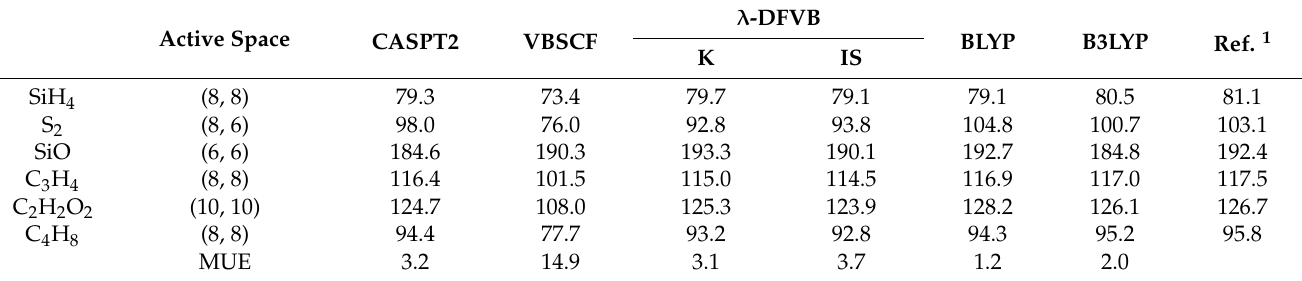
Table 3. Atomization energies per bond (in kcal/mol) of the six molecules in the AE6 dataset. Active Space